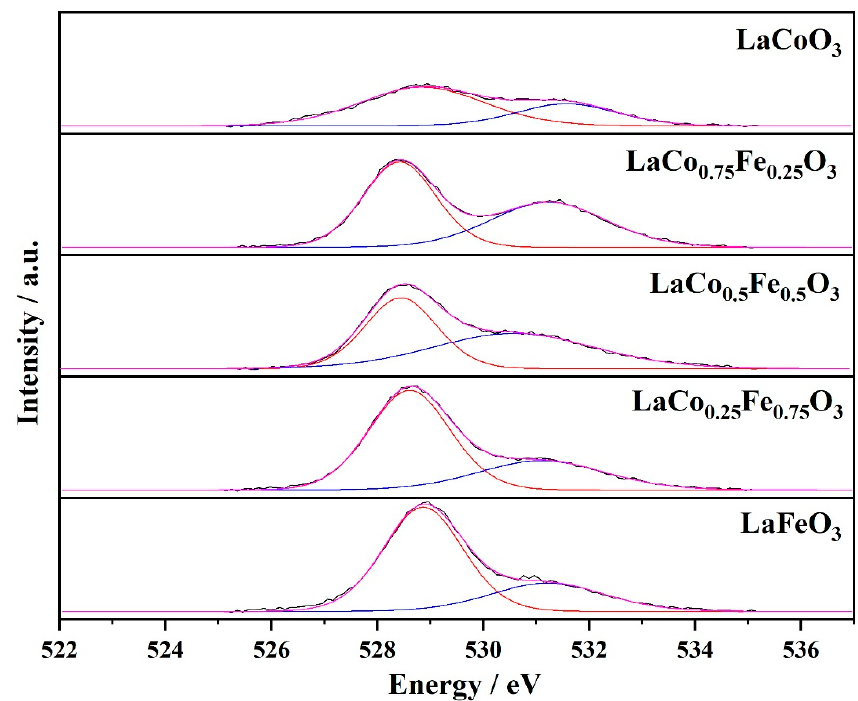
Figure 14. XPS spectra of O1s post-reaction.